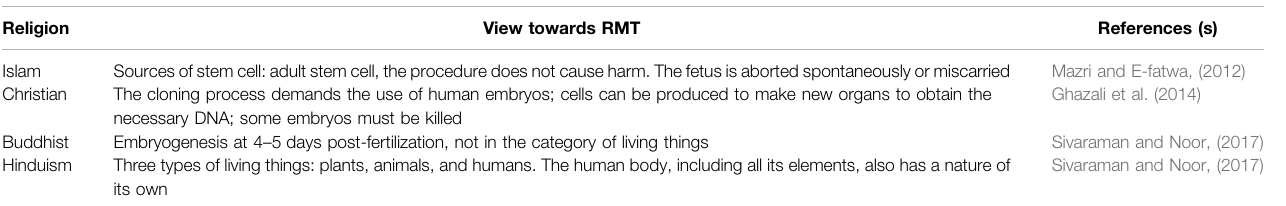
TABLE 6 | Cultural barriers against regenerative medicine therapy and local views on regenerative medicine therapy in Malaysia. Religion View towards